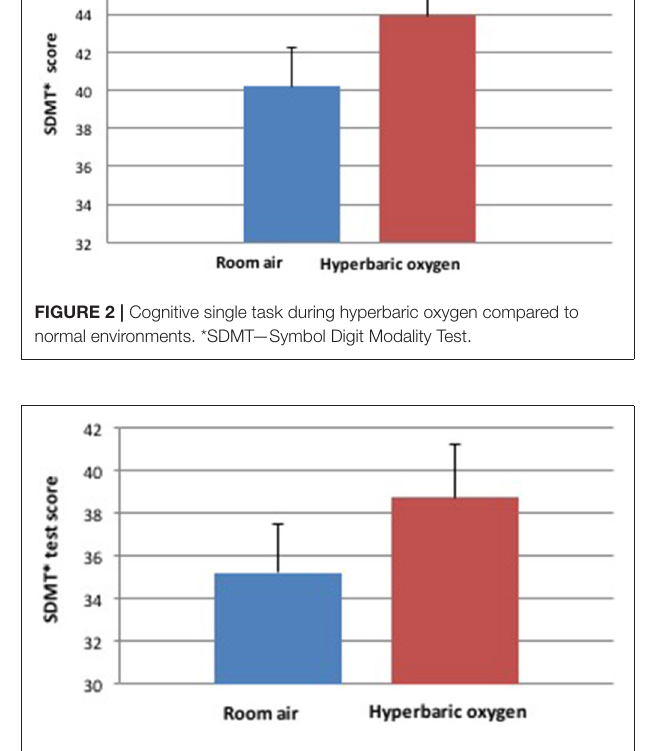
FIGURE 3 | Cognitive score during dual task during hyperbaric oxygen compared to normal environments. *SDMT—Symbol Digit Modality Test.